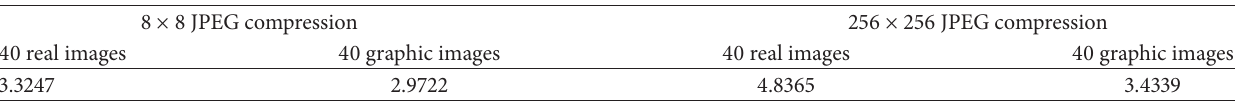
Table 7: The average compression ratio score of 8 × 8 JPEG compression and 256 × 256 JPEG compression using psychovisual